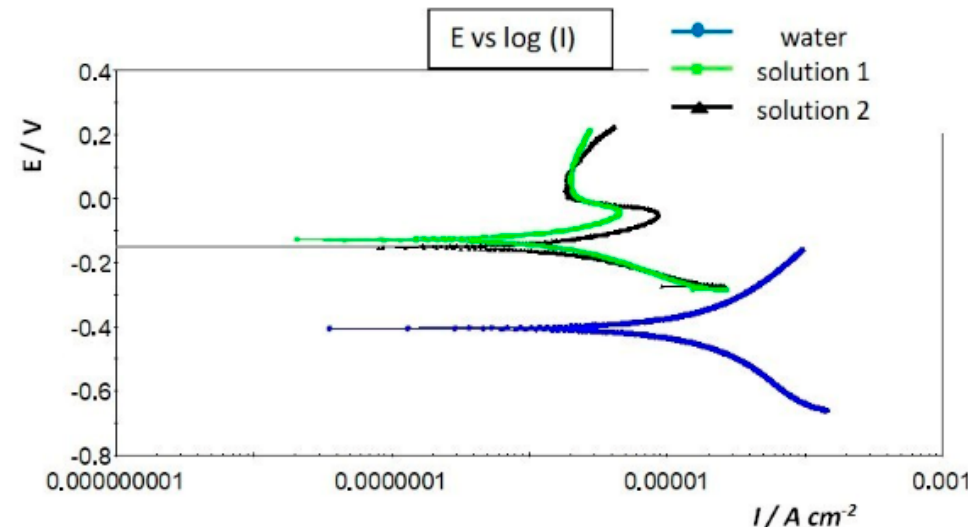
Figure 6. Polarisation curves of the tested HTCS-130 tool steel in water, solution 1, and solution 2.